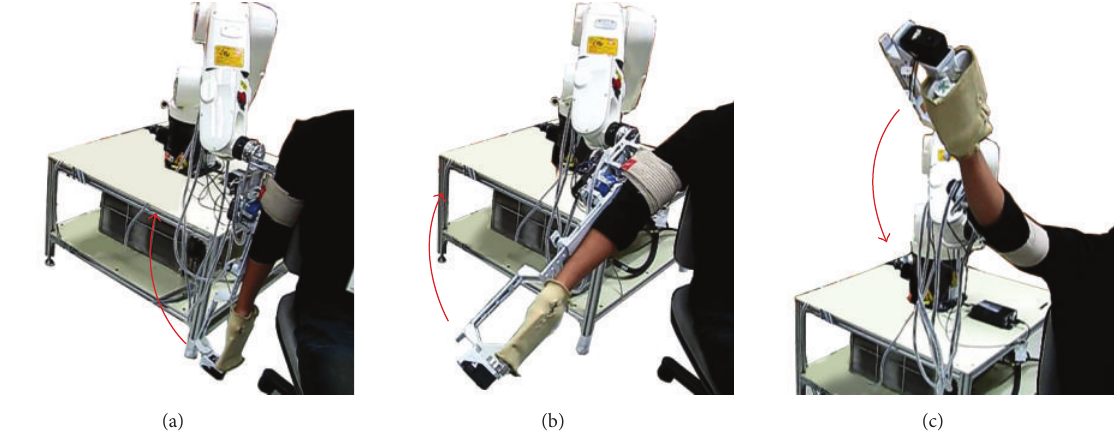
Figure 9: Example movements of SEFRE Rehab System: shoulder extension-flexion.